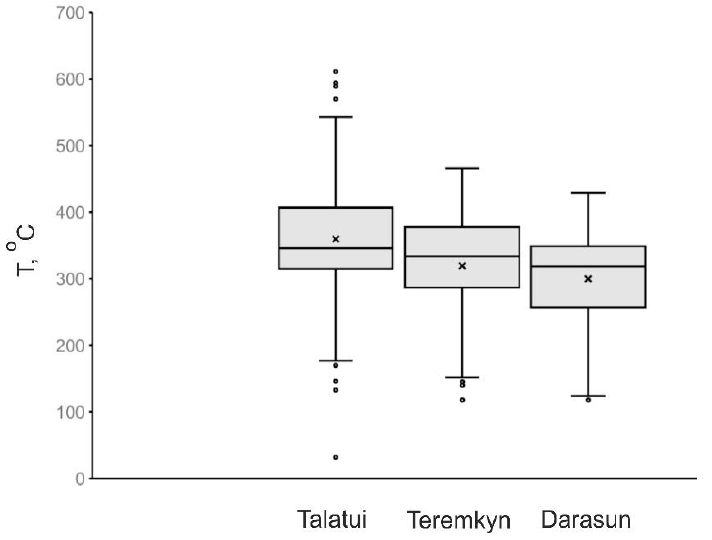
Figure 4. Homogenization temperature of fluid inclusions in quartz of gold ores of deposits of the Darasun goldfield. The figure format is the same as in Figure 2.